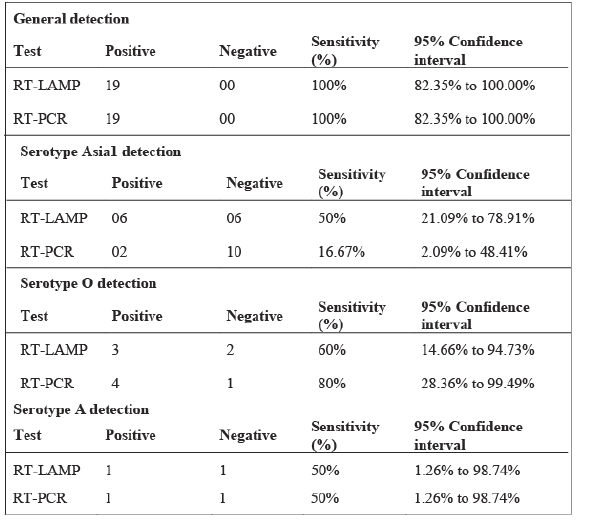
RT-LAMP was found more sensitive as it detected FMDV genome upto the 10-5 dilution while RT-PCR was able to detect 10-4 dilution of RNA template (figure 2). 3.4 Specificity